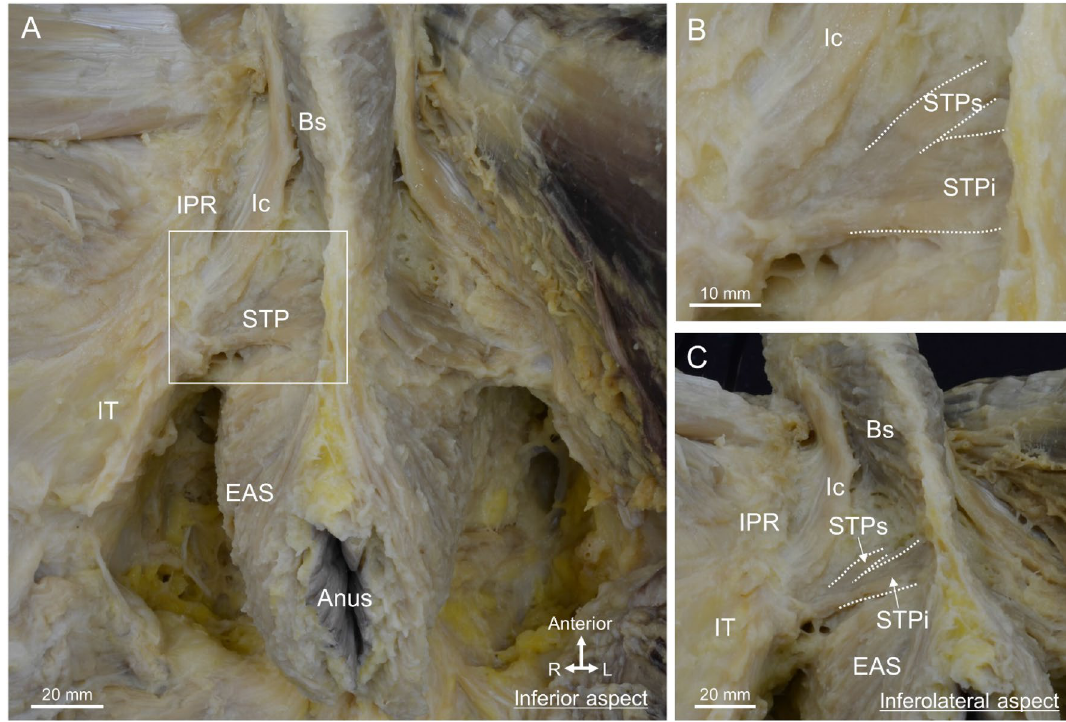
Figure 1. The central region of the male perineum where the perineal muscles gather. ( A ) The inferior aspect of the perineum, including the Bs, Ic, STP, and EAS muscles. ( B ) The magnified view of the rectangular space in ( A ). The STP was medially divided into two bundles, the STPs and STPi. ( C ) The inferolateral aspect, in which the pelvis was slightly tilted. The Bs and EAS were observed to be continuous. The Bs, EAS, and STP were concentrated in the central region of the perineum. Bs bulbospongiosus, EAS external anal sphincter, Ic ischiocavernosus, IPR ischiopubic ramus, IT ischial tuberosity, STP superficial transverse perineal muscle, STPi inferior bundle of STP, STPs superior bundle of